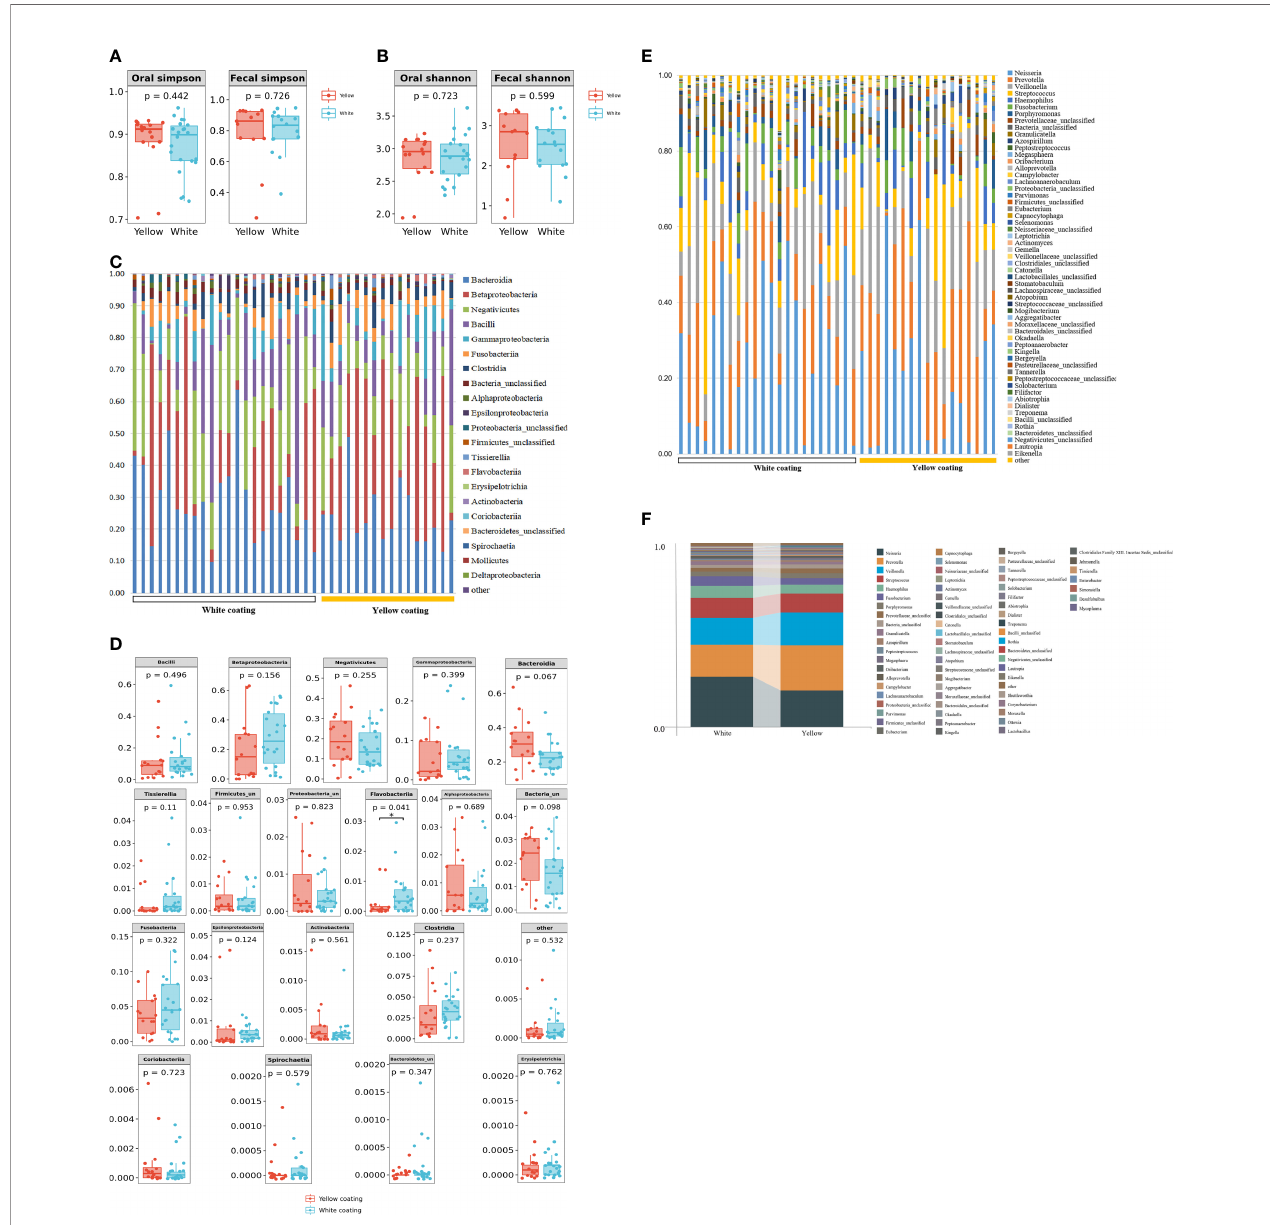
FIGURE 3 | Tongue coating and intestinal microbial information from MAFLD patients. Microbial diversity, which was calculated by the Shannon index (A) and Simpson index (B) , showed no signi fi cant differences between the two groups ( p > 0.05). (C, D) showed a statistically different fl ora at the class level. (E, F) showed a statistically different fl ora at the genus